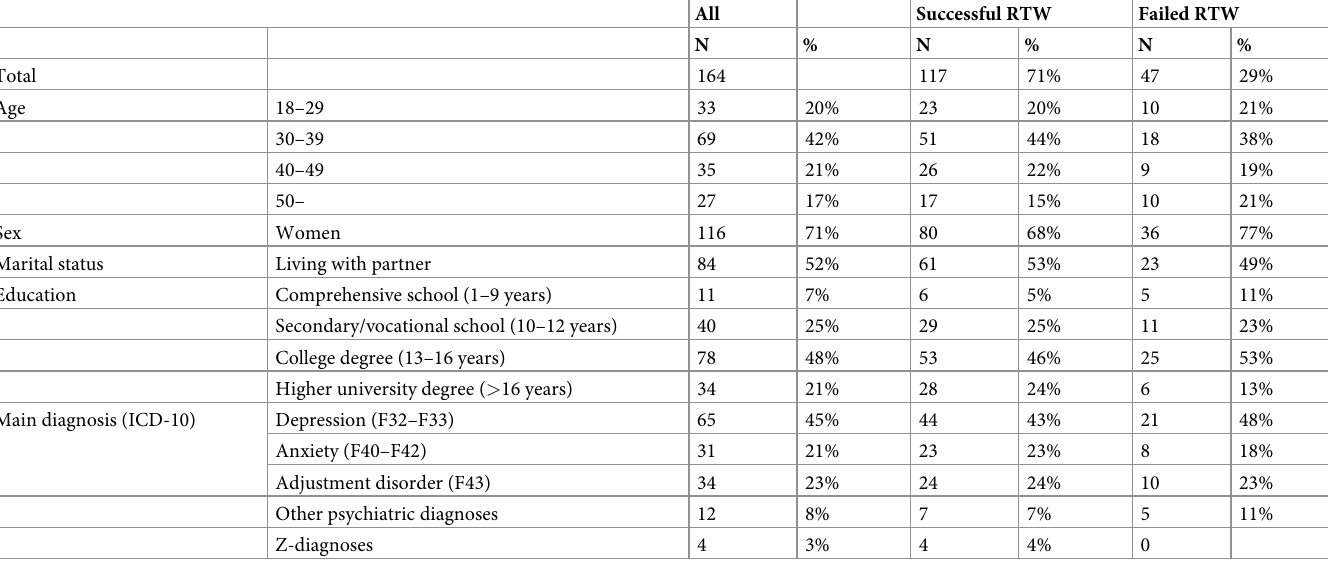
Table 1. Patient characteristics at baseline according to